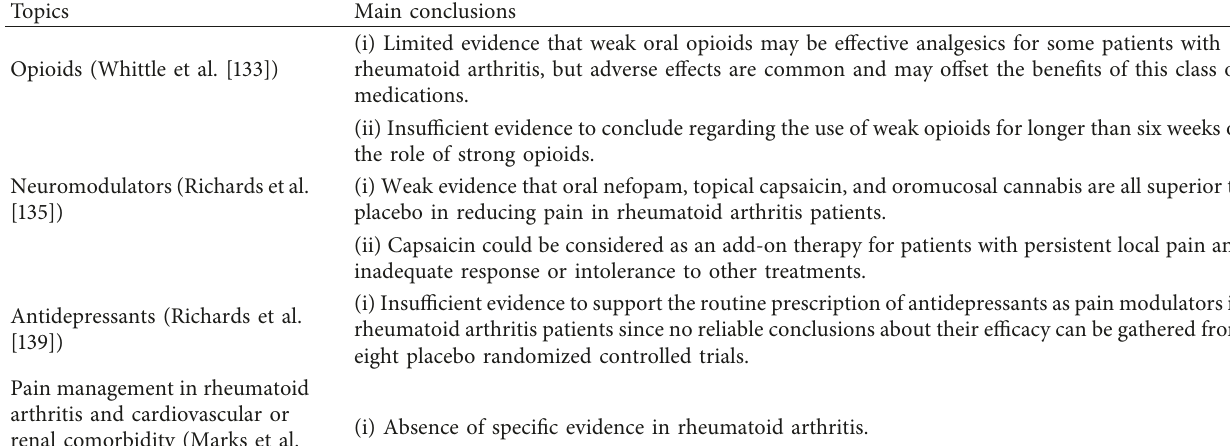
Table 2: Principal Cochrane systematic reviews on pain management in inflammatory